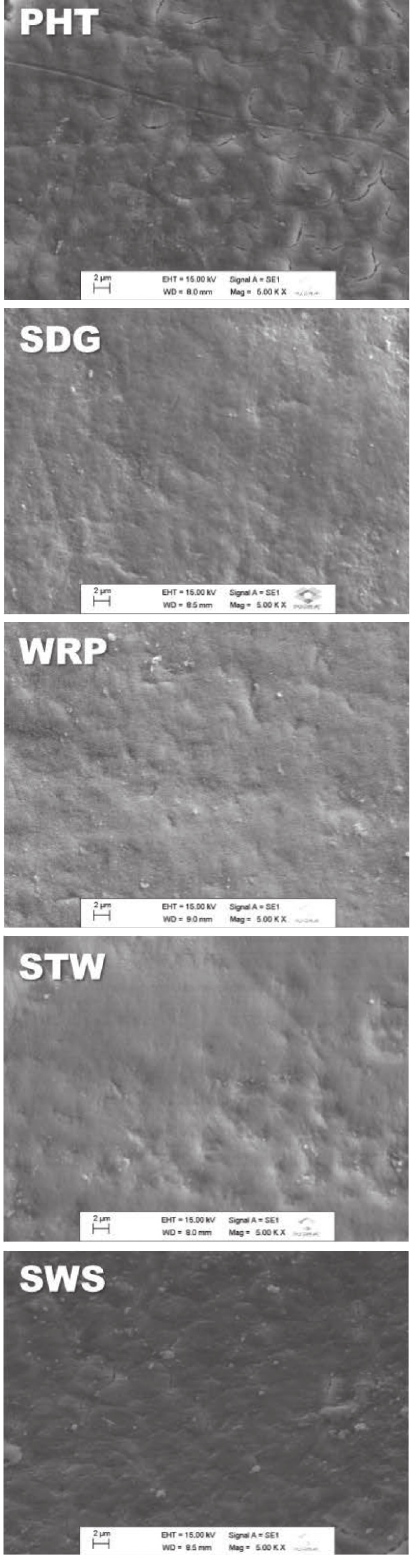
Figure 1: Representative images of Scanning Electron Microscopy analysis in different groups.